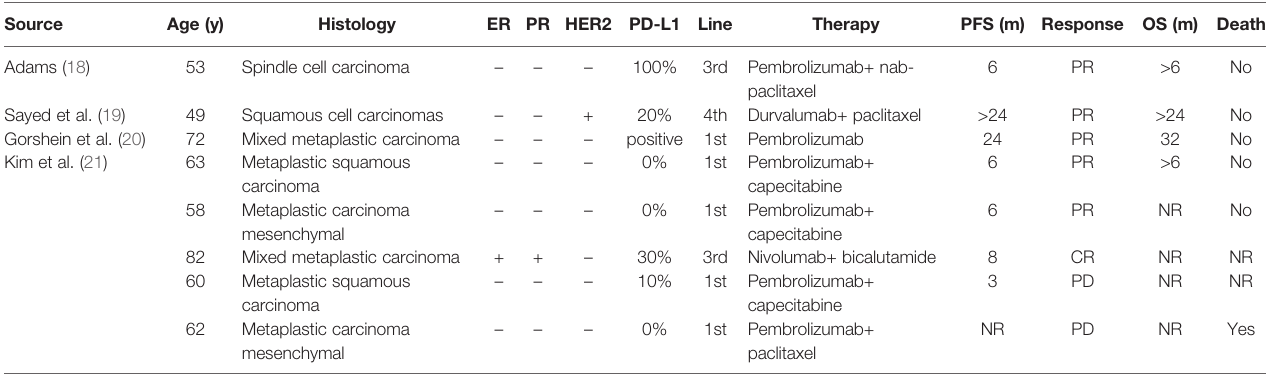
TABLE 1 | Summary of case reports observing the ef fi cacy of ICI in MBC.